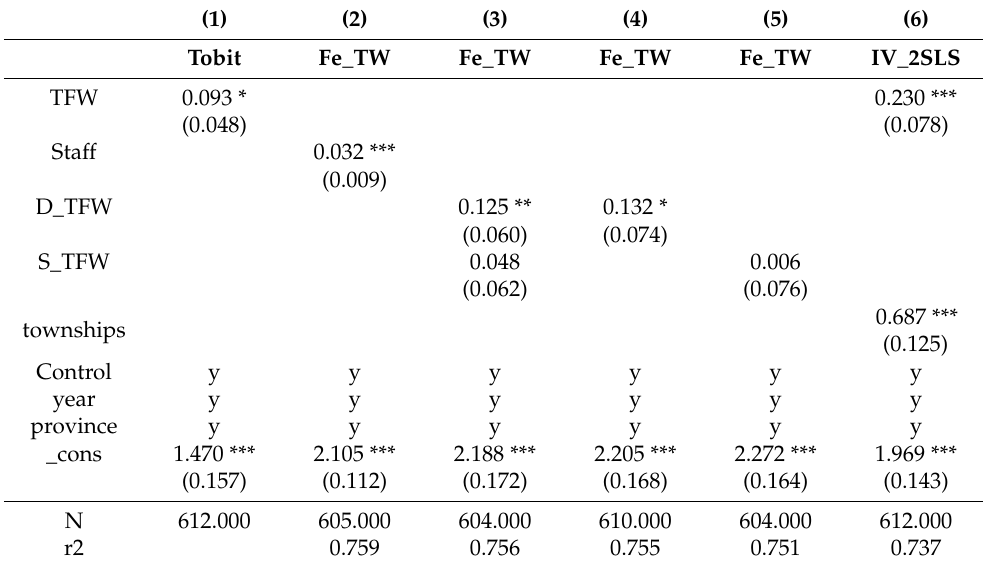
Table 3. Robustness test results of impacts of TFW on carbon density of collective